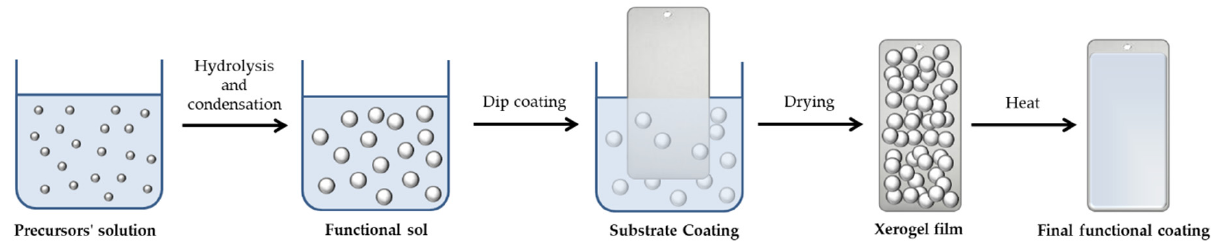
Figure 18. Schematization of the sol–gel process steps involving the preparation of the functional coating on metallic substrates.